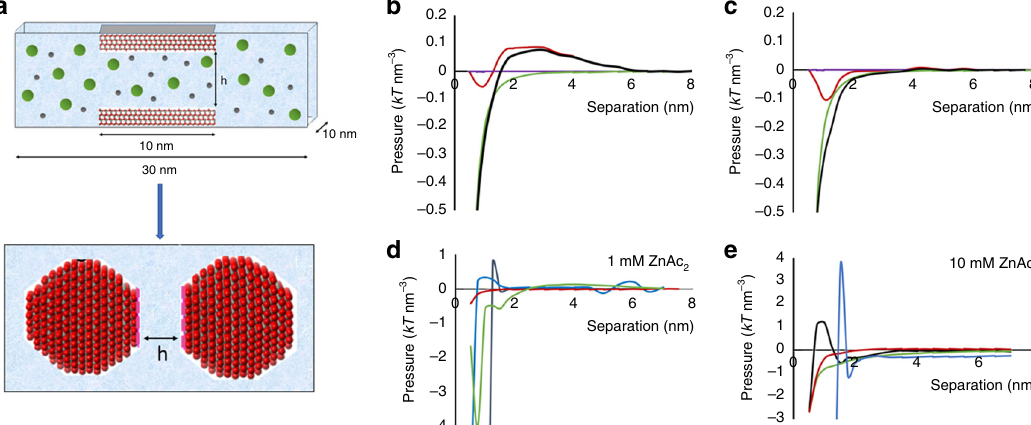
Fig. 5 cDFT simulations of ZnO particle attachment. a Schematic of cDFT simulation, b , c Disjoining pressure vs edge-to-edge separation between b two oppositely charged (0001) – (000-1) faces and c like-charged (0001) faces with aligned patterns of charges in 1 mM zinc acetate dihydrate solution in methanol calculated using the primitive model showing electric double layer (blue), ion correlation (red), hard sphere (purple), and van der Waals (green), and total (black) components of pressure. d , e Total disjoining pressure between pairs of ZnO facets in d 1 mM and e 10 mM zinc acetate dihydrate solution in methanol calculated using the full model for (0001 – (0001) (black), (10-10) – (10-10) (green), (0001) – (10-10) (red), and (0001 – (000-1) (blue) con fi gurations. The charge patterns for (0001) – (000-1) faces are misaligned by 20 degrees (the corresponding data for aligned pattern of charges are provided in Supplementary Fig.